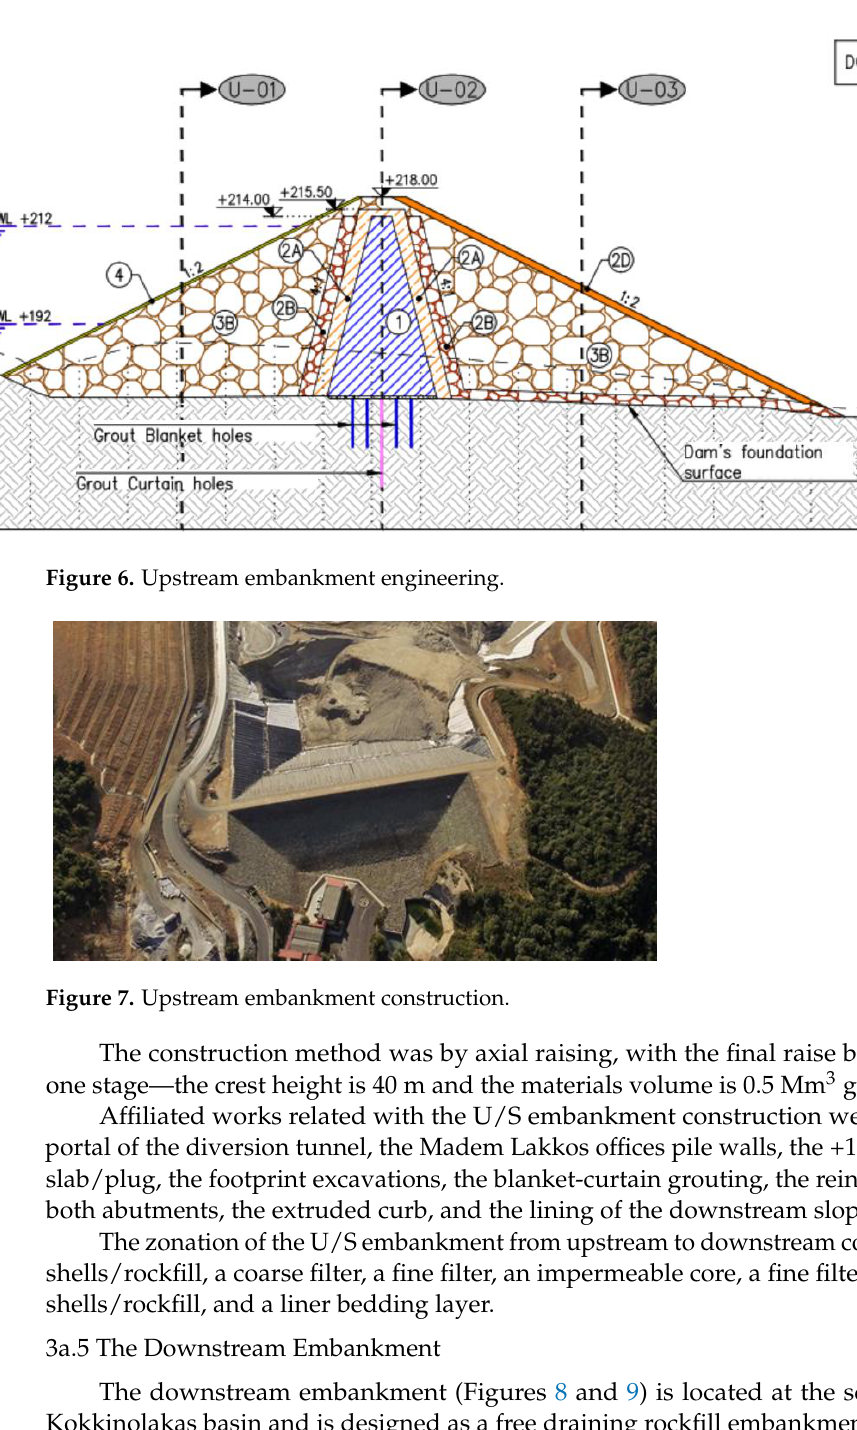
Figure 8. Downstream embankment engineering.